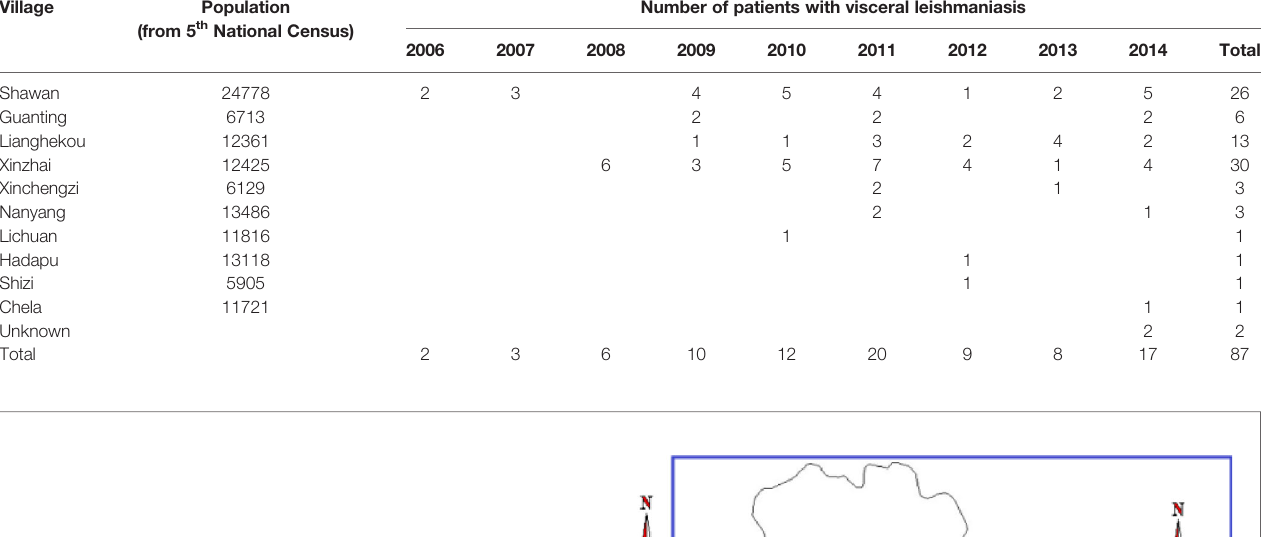
TABLE 1 | Distribution of Visceral Leishmaniasis Cases in the Tan Chang County (up to 2014). Village Population (from 5 th National Census)